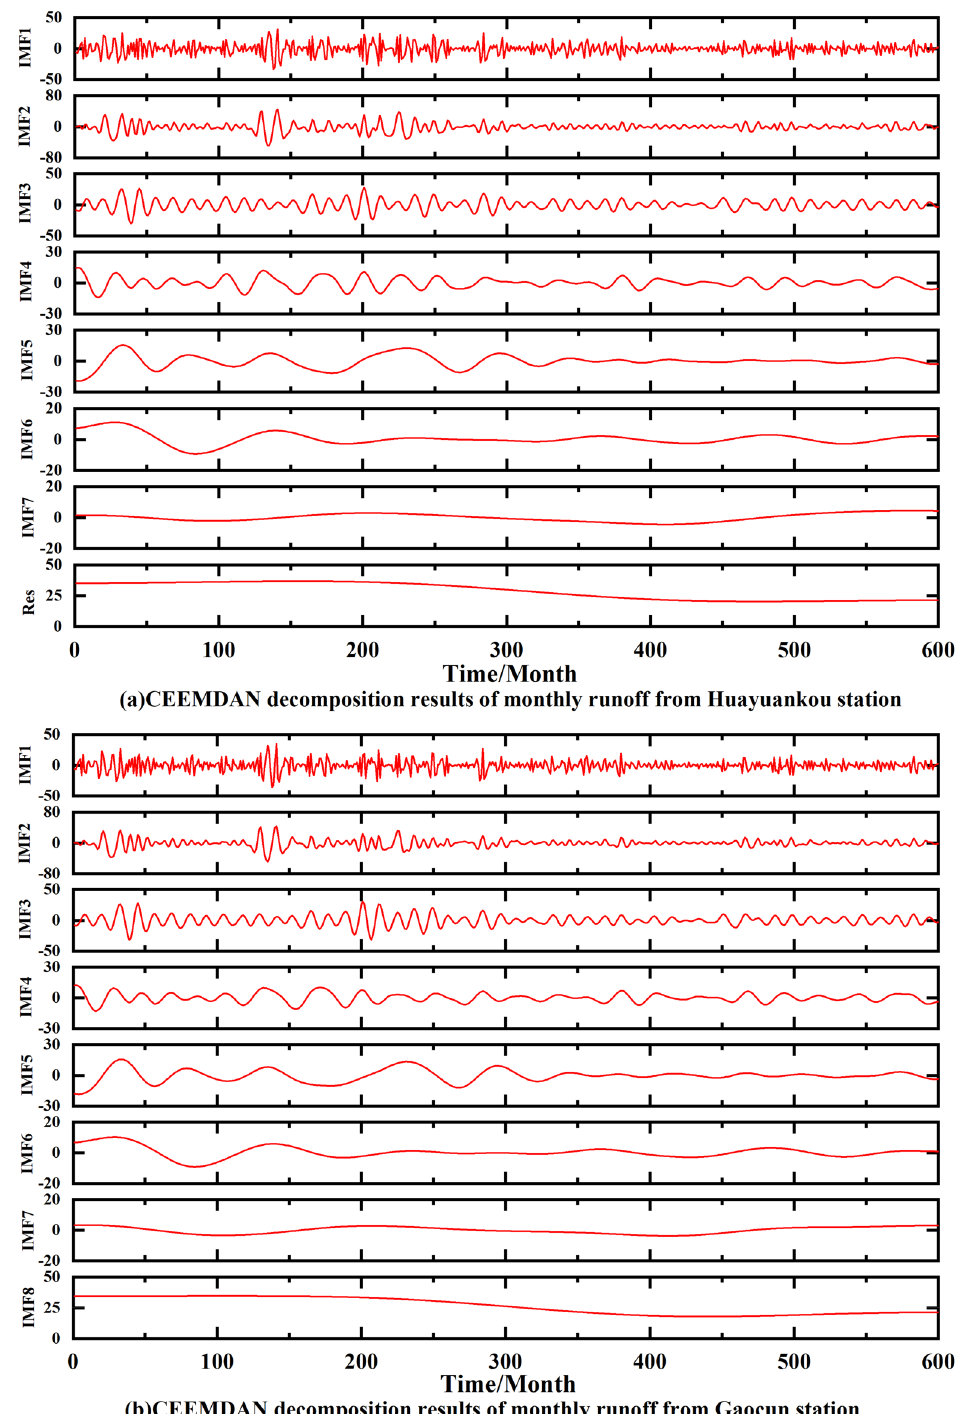
Figure 7. Monthly runoff data from the lower Yellow River stations using CEEMDAN